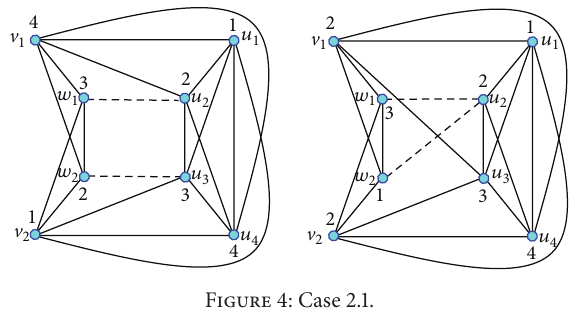
Figure 3: Case 1.